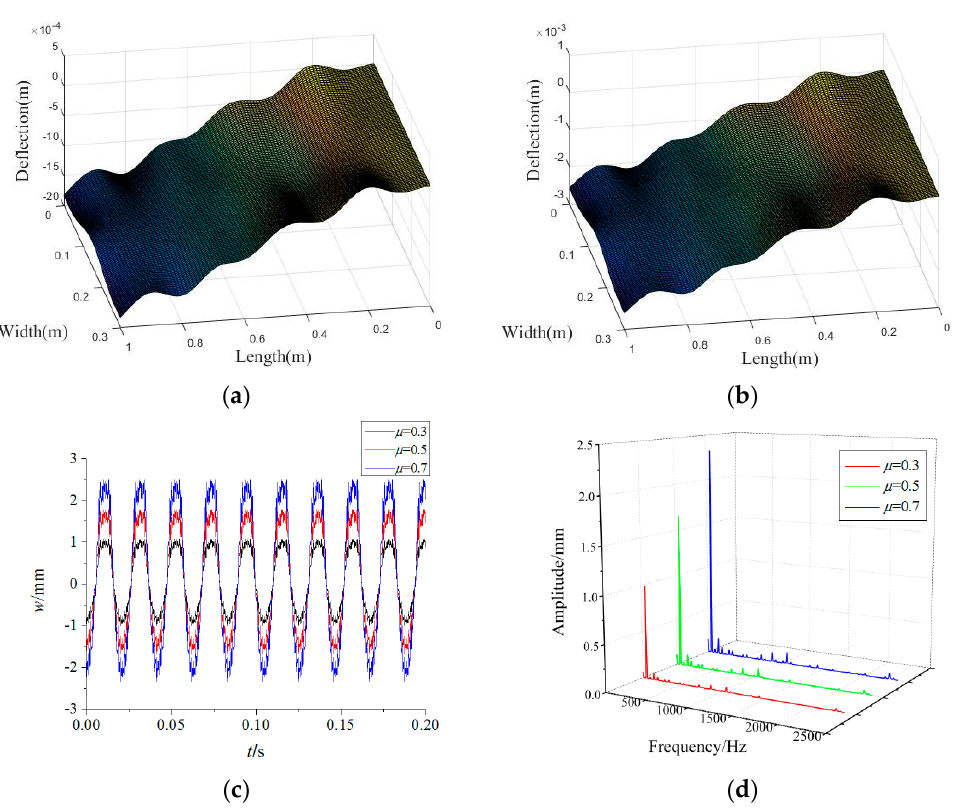
Figure 7. Effects of friction coefficients on forced vibration responses of the rotating FGM plate ( a ) μ = 0.5, ( b ) μ = 0.7, ( c ) time-domain response, ( d ) frequency-domain response.